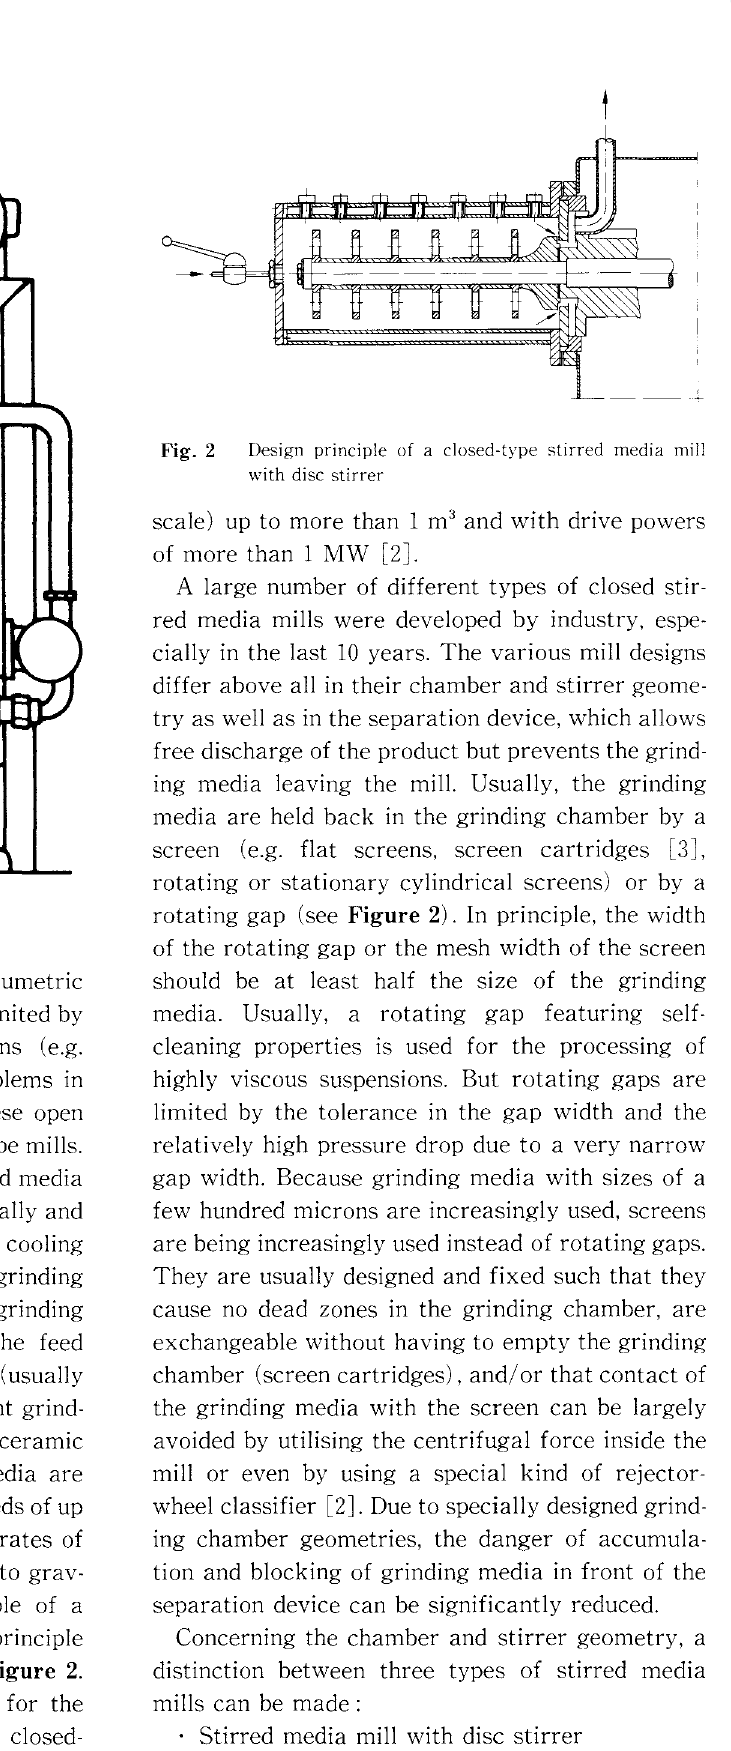
Fig. 2 Design principle of a closed-type stirred media mill with disc stirrer scale) up to more than 1 m 3 and with drive powers of more than 1 MW